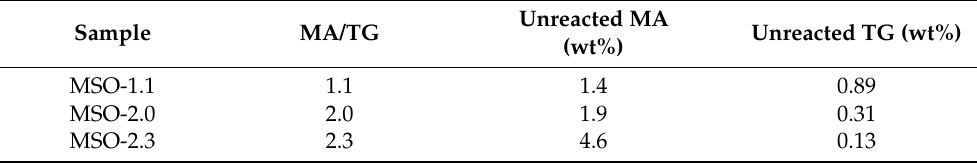
Table 4. Maleated soybean oil products previously synthesized in our laboratory used for the modification of starch